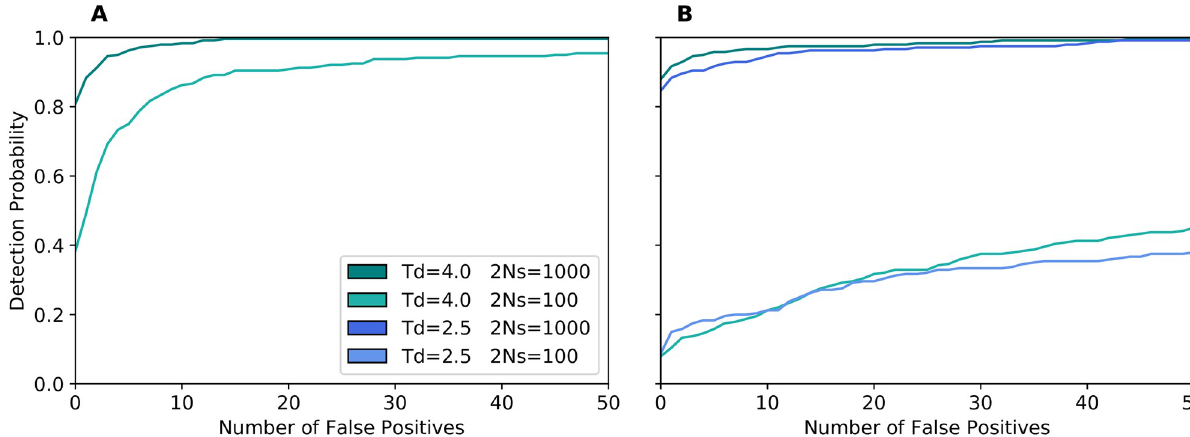
Fig 4. Power to detect the adaptive introgression allele. Here we plot the detection probability for VolcanoFinder as a function of the number of false positive signals from the genomic background that produce a higher peak. Panel A shows introgression from a rare hybridization event. Panel B shows introgression with higher migration rates: m = 30/ N for strong selection 2 Ns = 1000 and m = 300/ N for weak selection 2 Ns = 100. Divergence of the donor is T d = 4.0 (green) or T d = 2.5 (blue) in units of 4 N generations. Here, N = 10, 000 diploid individuals, mutation rate μ = 1.25 × 10 − 8 per site per generation, and recombination rate r = 5 × 10 − 7 per site per generation.